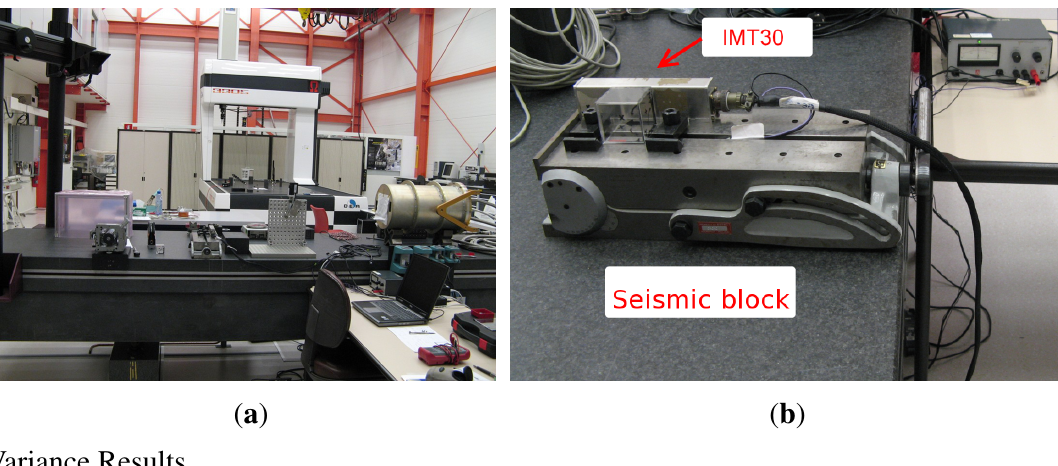
Figure 4. Metrology laboratory at ESA/ ESTEC. ( a ) General view with the seismic block in the foreground; ( b ) IMT30 on the seismic block while testing.